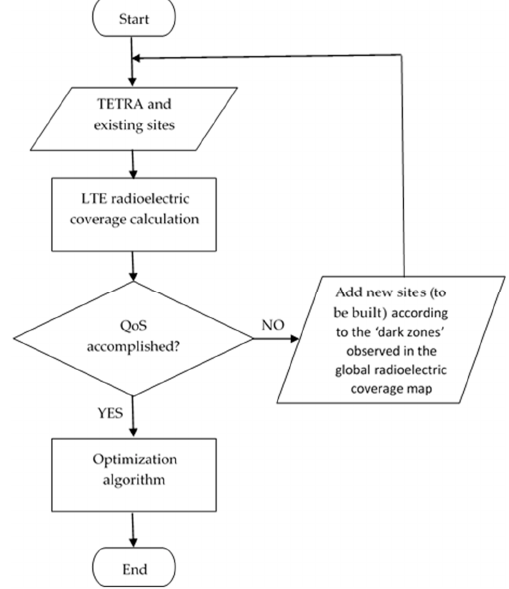
Figure 5. The proposed flow-chart to plan the new LTE network.